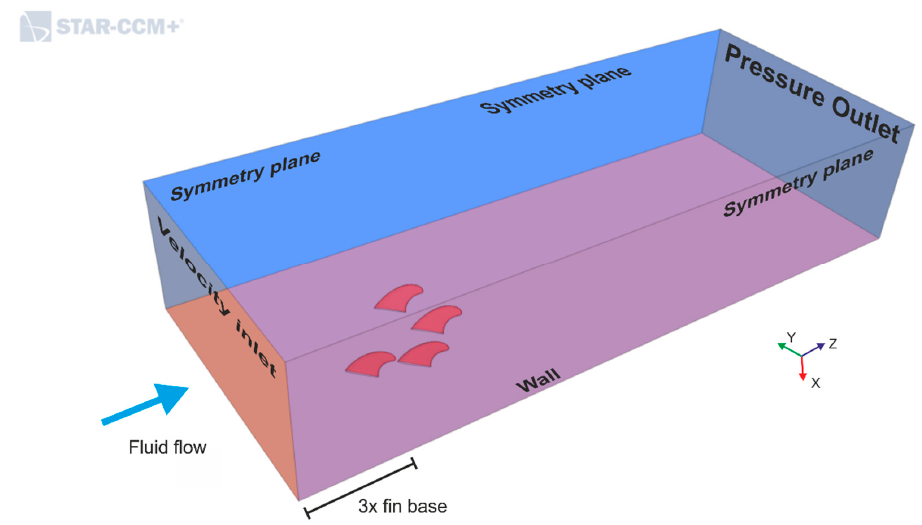
Figure 8. The geometry and boundary conditions of the numerical simulation region with the commercial 4-fins configuration at an AoA of 45°. The surfaces of the fins are also defined as